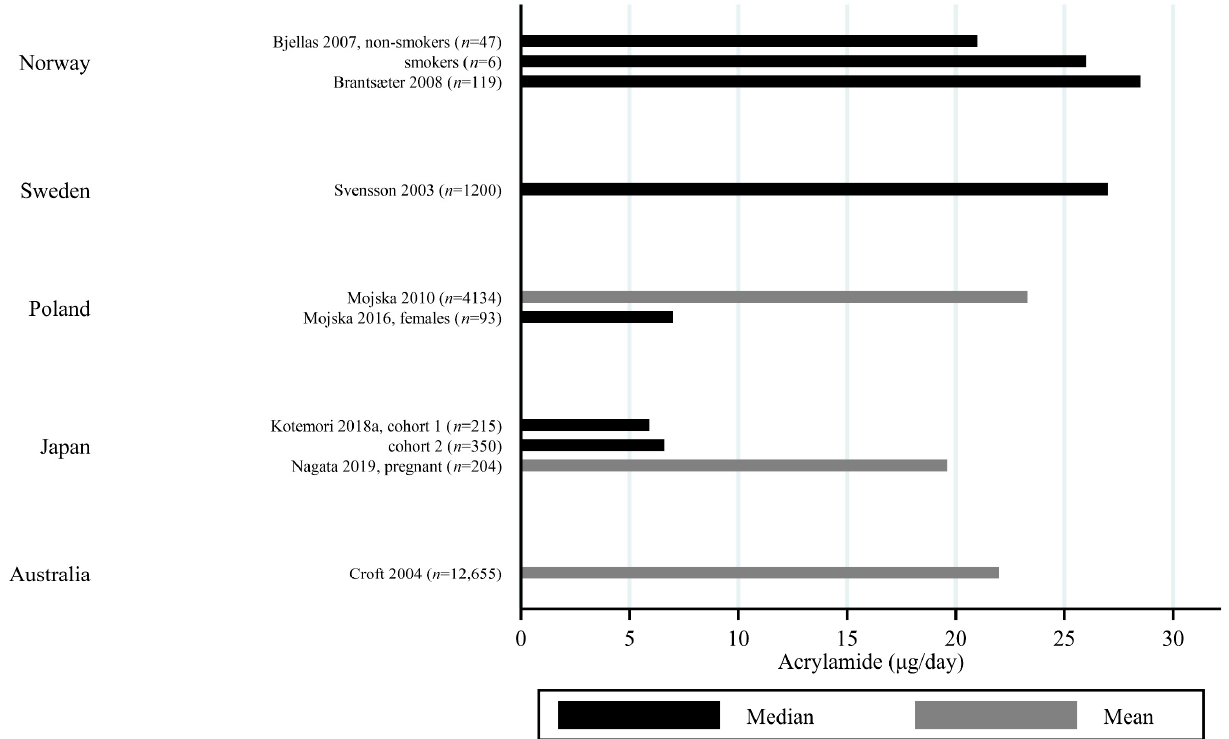
Toxics 2021 , 9 , x FOR PEER REVIEW Figure 6. Median/mean estimated daily acrylamide intake ( µ g/day), based on dietary recall by country. Figure 6. Median/mean estimated daily acrylamide intake ( μ g/day), based on dietary recall by country.